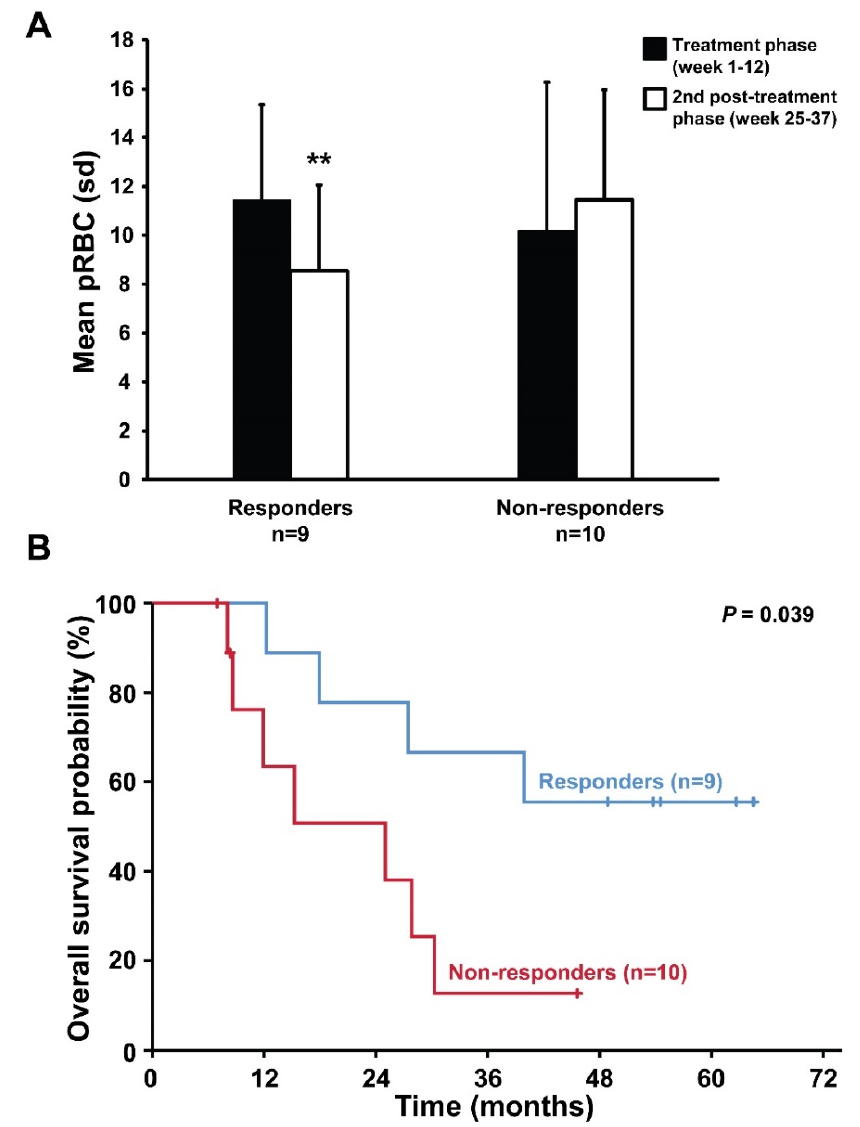
Figure 1. Transfusion requirement and survival analysis according to response to treatment with asunercept. ( A ) Mean number of transfused packed red blood cells (pRBC) during the treatment phase (week 1–12) and second half of the post-treatment phase (week 25–37) in responding versus non-responding patients (sd, standard deviation; ** p < 0.01). ( B ) In retrospective post hoc analysis, response to asunercept was associated with improved overall survival (OS, logrank p = 0.039). After a median follow-up of 54 months (range 7–65), OS at 3 years was 67% (95% CI 36–97) in responding patients versus 13% (95% CI 0–36) in non-responding patients.